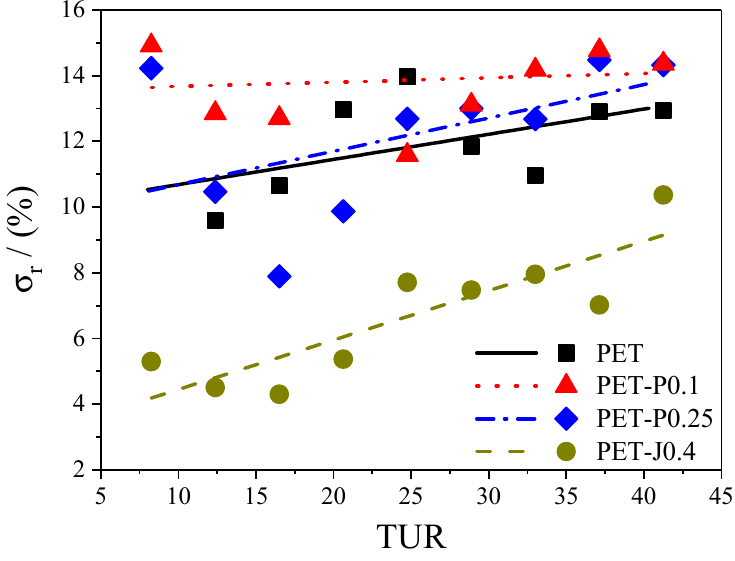
Figure 10. Non-uniformity index σ R as a function of take-up ratio TUR for PET modified with PMDA or Joncryl. The lines are a guide to the eye.